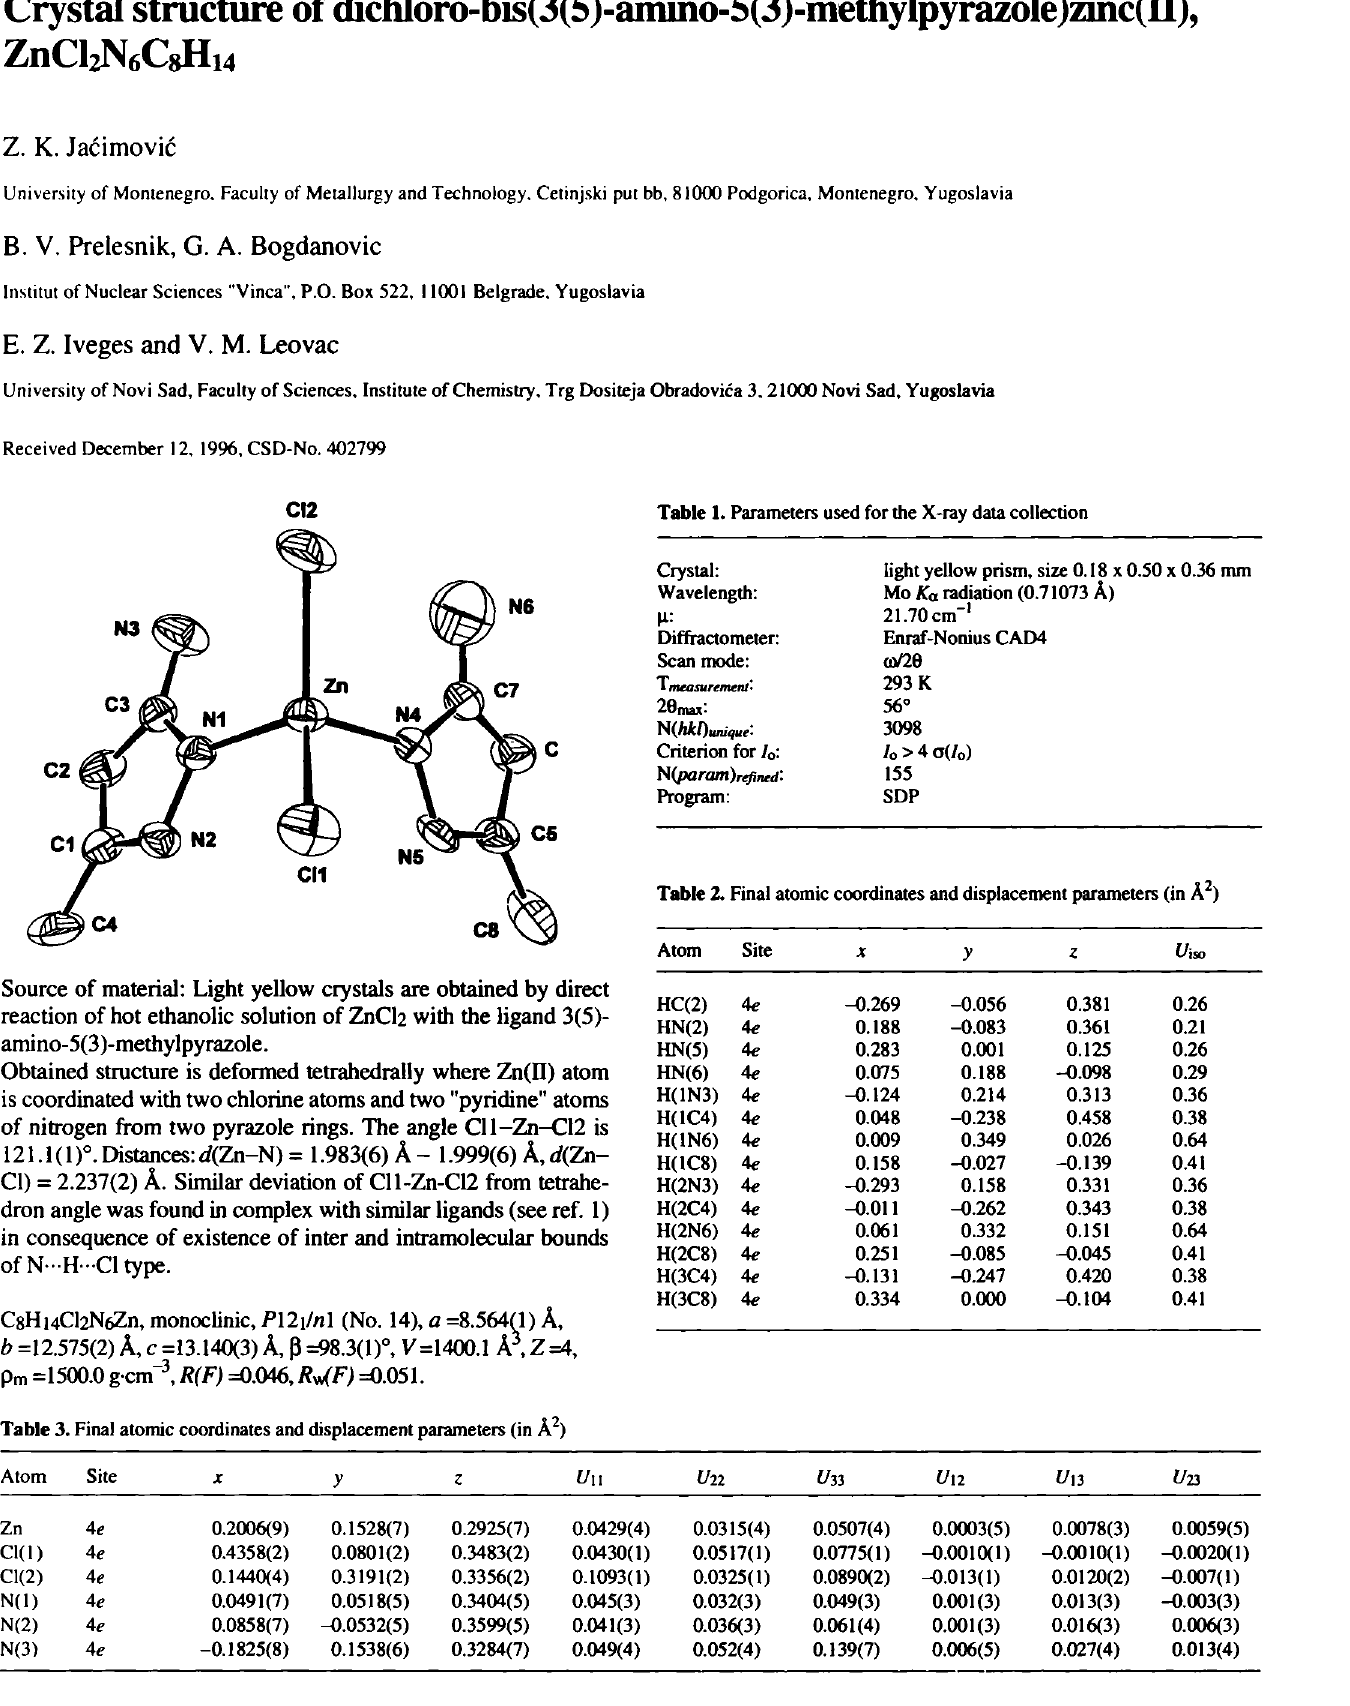
amino-5(3)-methylpyrazole.